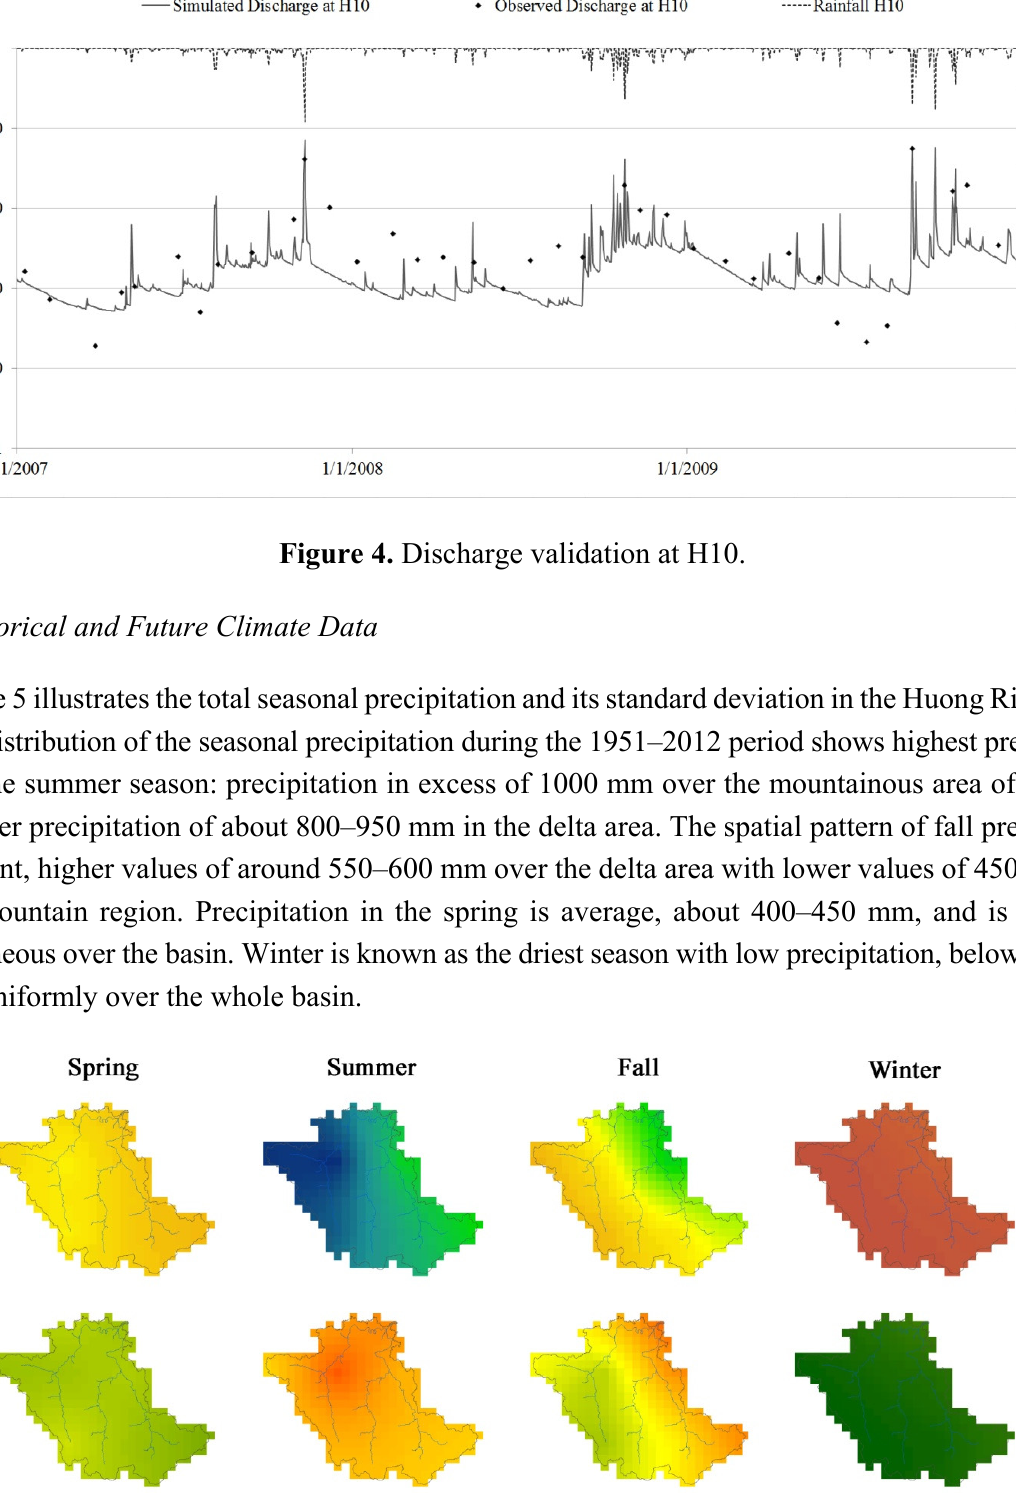
Figure 5. Seasonal precipitation distribution and their standard